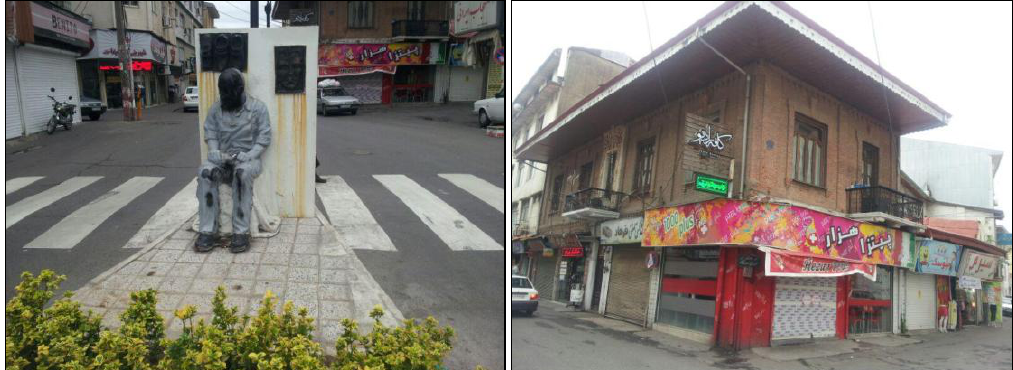
Figure 2. Entrance of Neighbourhood Figure 3. Historical Buildings